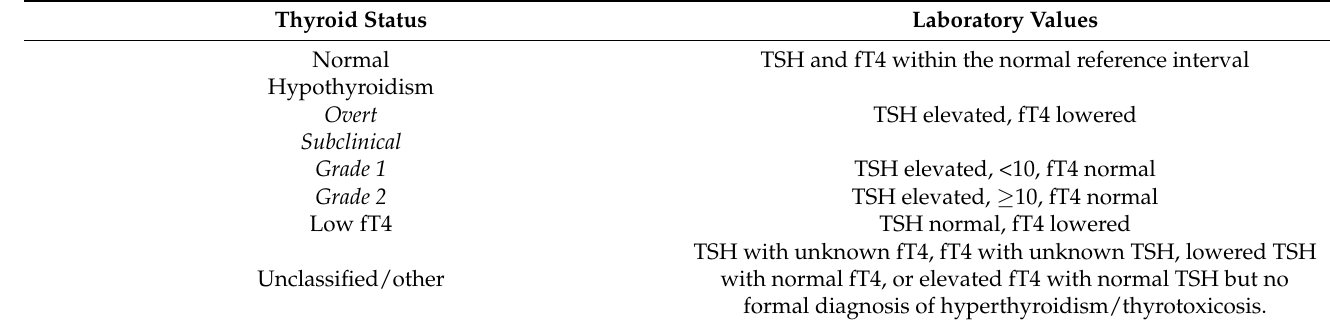
Table 1. Categorisation of thyroid status at start of thyroid hormone replacement